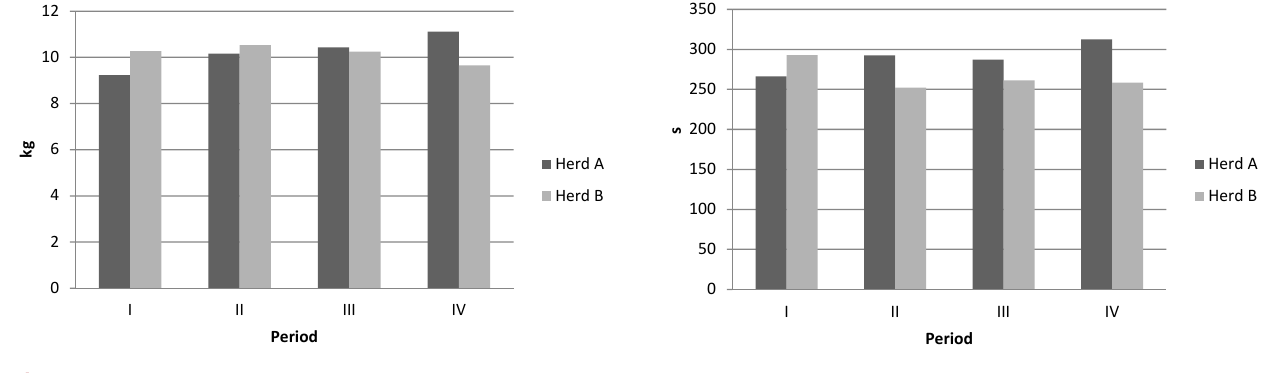
Figure 3. Level of milking duration in herds under